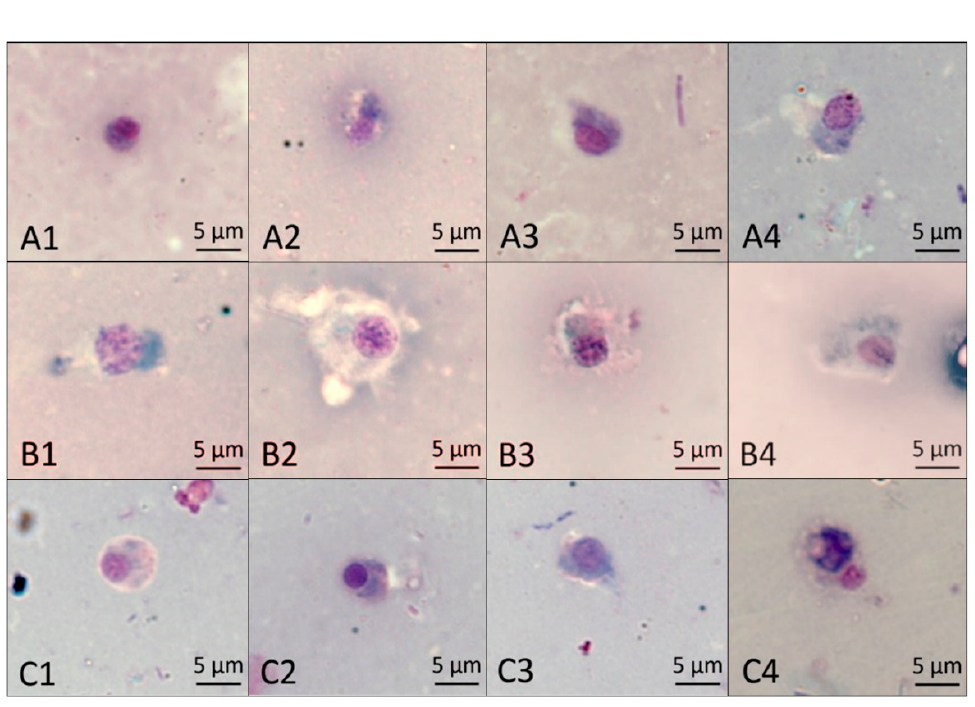
Figure 7. The effect of different treatments on P. canaliculata hemocyte basophilic granulocytes. ( A1 – A4 ) show the effect of different treatments, CK, PA, NI, and MI, on basophilic granulocytes at 48 h; ( B1 – B4 ) show the effect of different treatments, CK, PA, NI, and MI, on basophilic granulocytes at 60 h; ( C1 – C4 ) show the effect of different treatments, CK, PA, NI, and MI, on basophilic granulocytes at 72